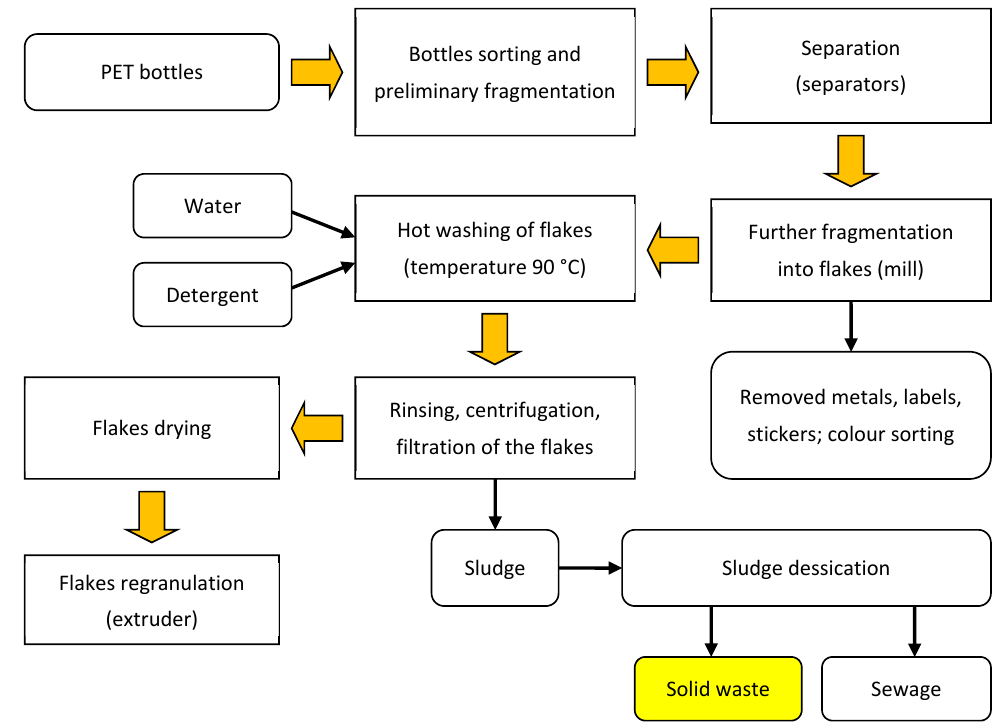
Figure 1. Schematic demonstration of processes used in polyethylene terephthalate (PET) bottle processing during their recycling. The material under investigation is the solid waste marked in yellow.